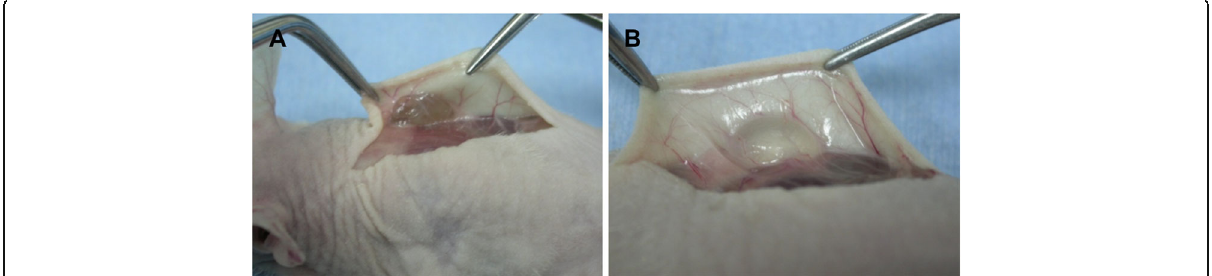
Fig. 1 Macroscopic view. Hydrogel ( a ) and hyaluronan gel filler ( b ) groups just before sacrifice (8 weeks after surgery). The material remained as a yellow-white